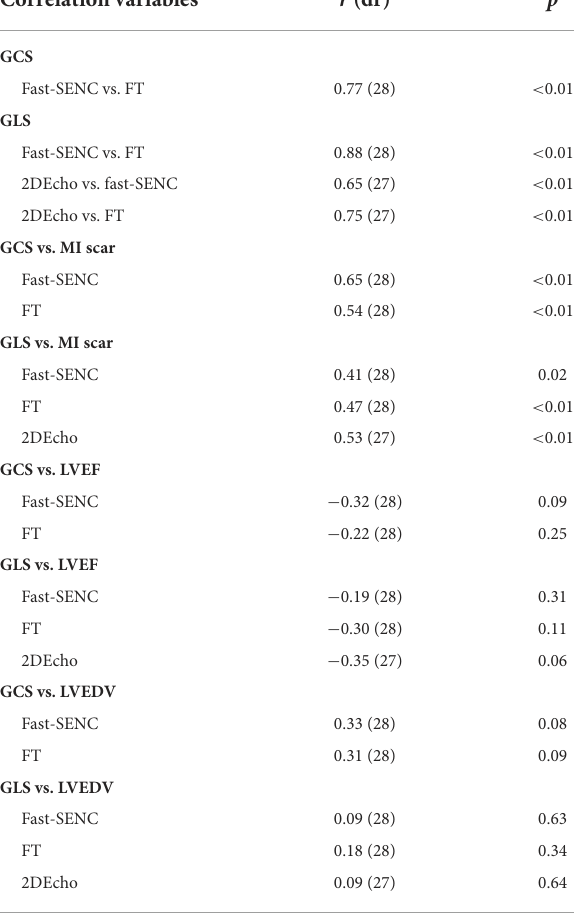
TABLE 3 Correlation chart of global